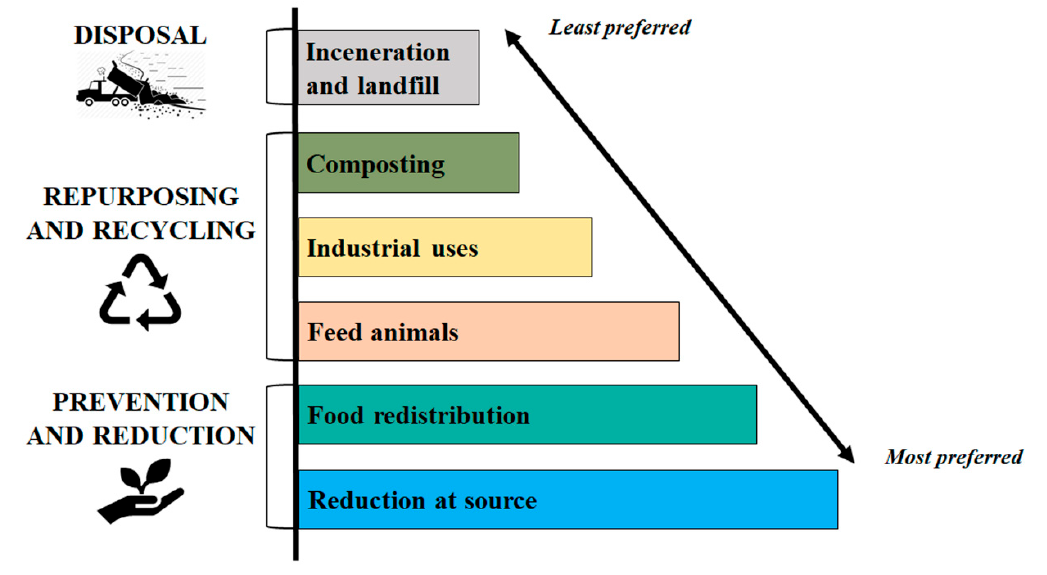
Figure 1. Hierarchy model for the management of food waste and loss [5].